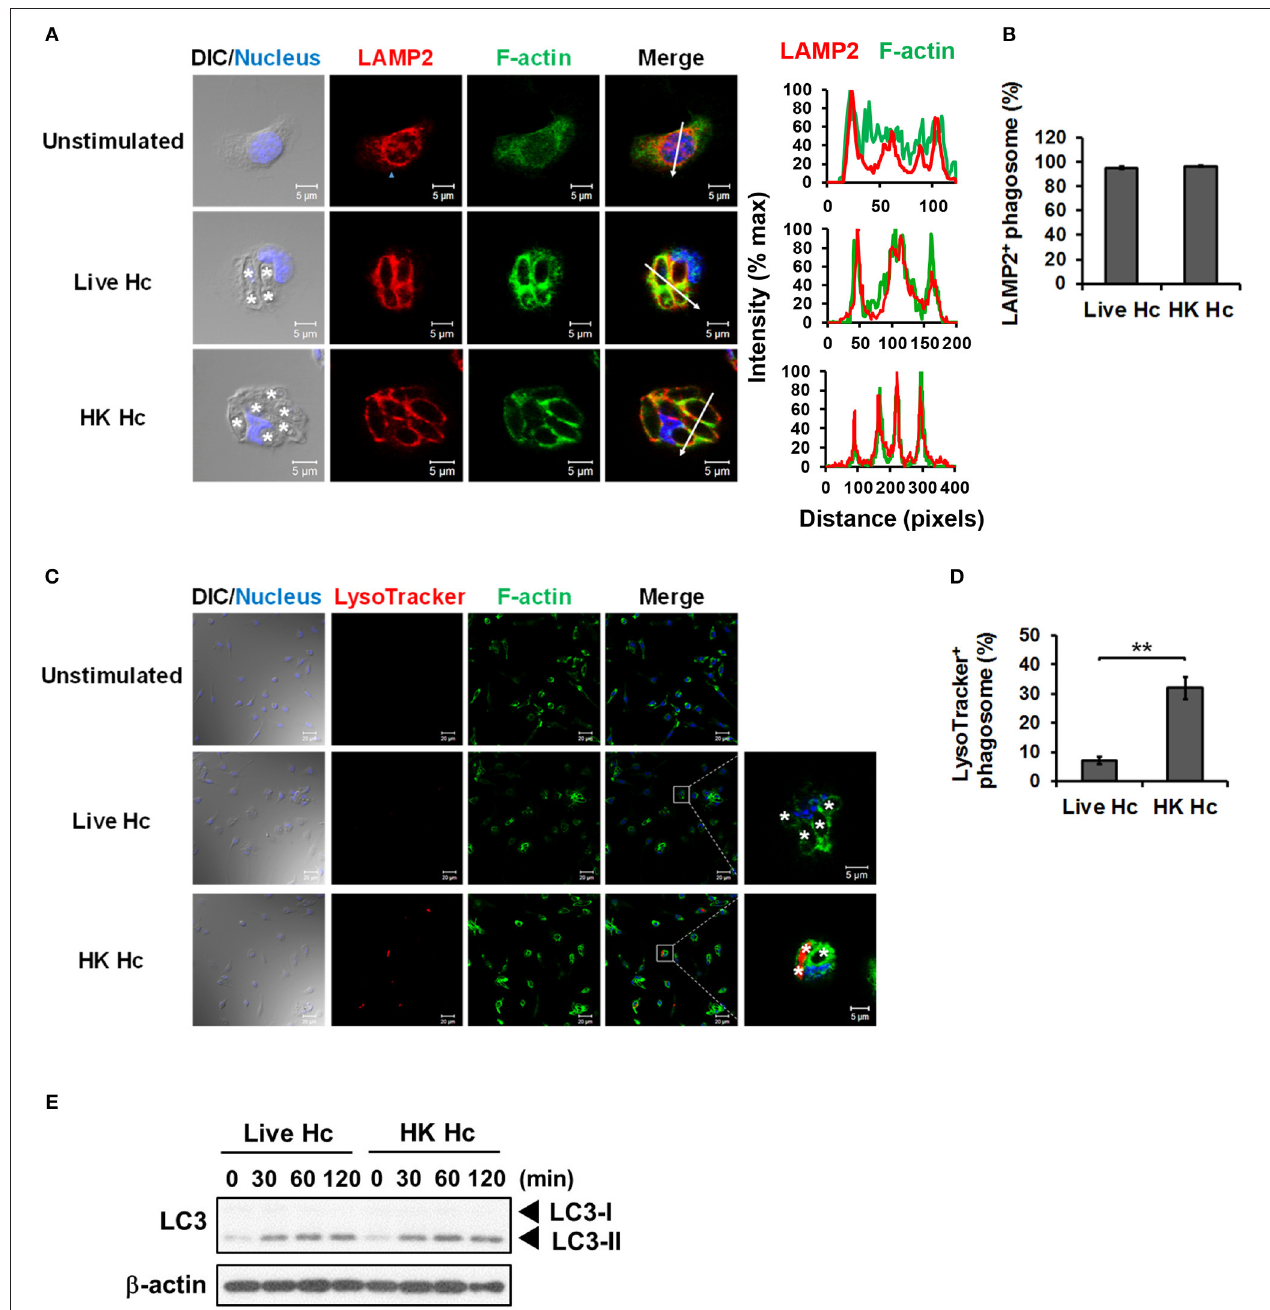
FIGURE 7 | Viable H. capsulatum prevents phagosomal acidification in macrophages. (A,B) Macrophages from WT mice were stimulated with or without live or heat-killed (HK) H. capsulatum (MOI = 5) for 4h. Cells were fixed and stained for LAMP2 (red), F-actin (green), and nucleus compartment (blue). Cells were viewed under confocal microscope. Asterisks in the DIC/Nucleus field point to H. capsulatum yeasts. The intensity of different fluorochromes along the white arrow in the merged image is shown as the histogram on the right. Phagosomes in each cell were counted and the percentages of LAMP2 + phagosome in cells taking up live and heat-killed fungus are shown as mean ± SEM in bar graphs ( n = 3) (B) . (C,D) Macrophages from WT mice were stimulated with or without live or heat-killed (HK) H. capsulatum (MOI = 5) for 2h and unengulfed yeasts were washed off. Macrophages were then culture in 100nM LysoTracker Red for additional 2h to detect phagolysosomal acidification. Cell were fixed and stained for F-actin (green) and nucleus compartment (blue). Cells were viewed under confocal microscope. Box areas are shown at higher magnification in the left of the corresponding image and asterisks in the magnified field point to H. capsulatum yeasts. Data shown are representative of 3 independent experiments with similar results (A,C) . Phagosomes in each cell were counted and the percentages of LysoTracker + phagosome in cells taking up live and heat-killed H. capsulatum are shown. (E) Macrophages from WT mice were stimulated with or without (0min) live or heat-killed (HK) H. capsulatum (MOI = 5) for 30, 60, 90, and 120min. Cell lysates were extracted and analyzed by Western blotting. Bars represent the mean ± SEM ( n = 4) (D) . ** p ≤ 0.01 [2-tailed t -test (B,D) ].